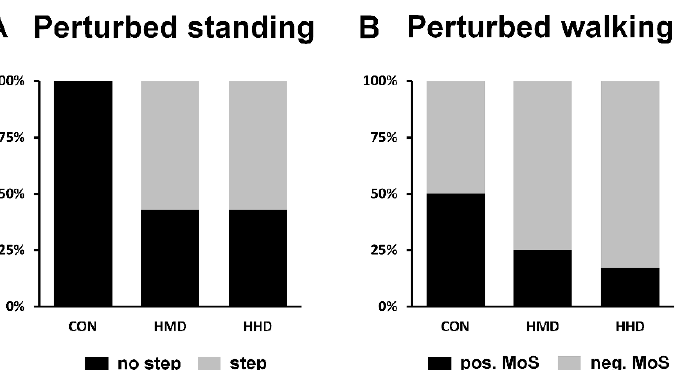
Figure 2. ( A ) Percentage of participants who required to regain balance in perturbed standing with and without taking a step for control condition (CON), head-mounted display (HMD) and hand-held display (HHD). ( B ) Percentage of participants with negative and positive MoS for CON, HMD and HHD for perturbed walking.